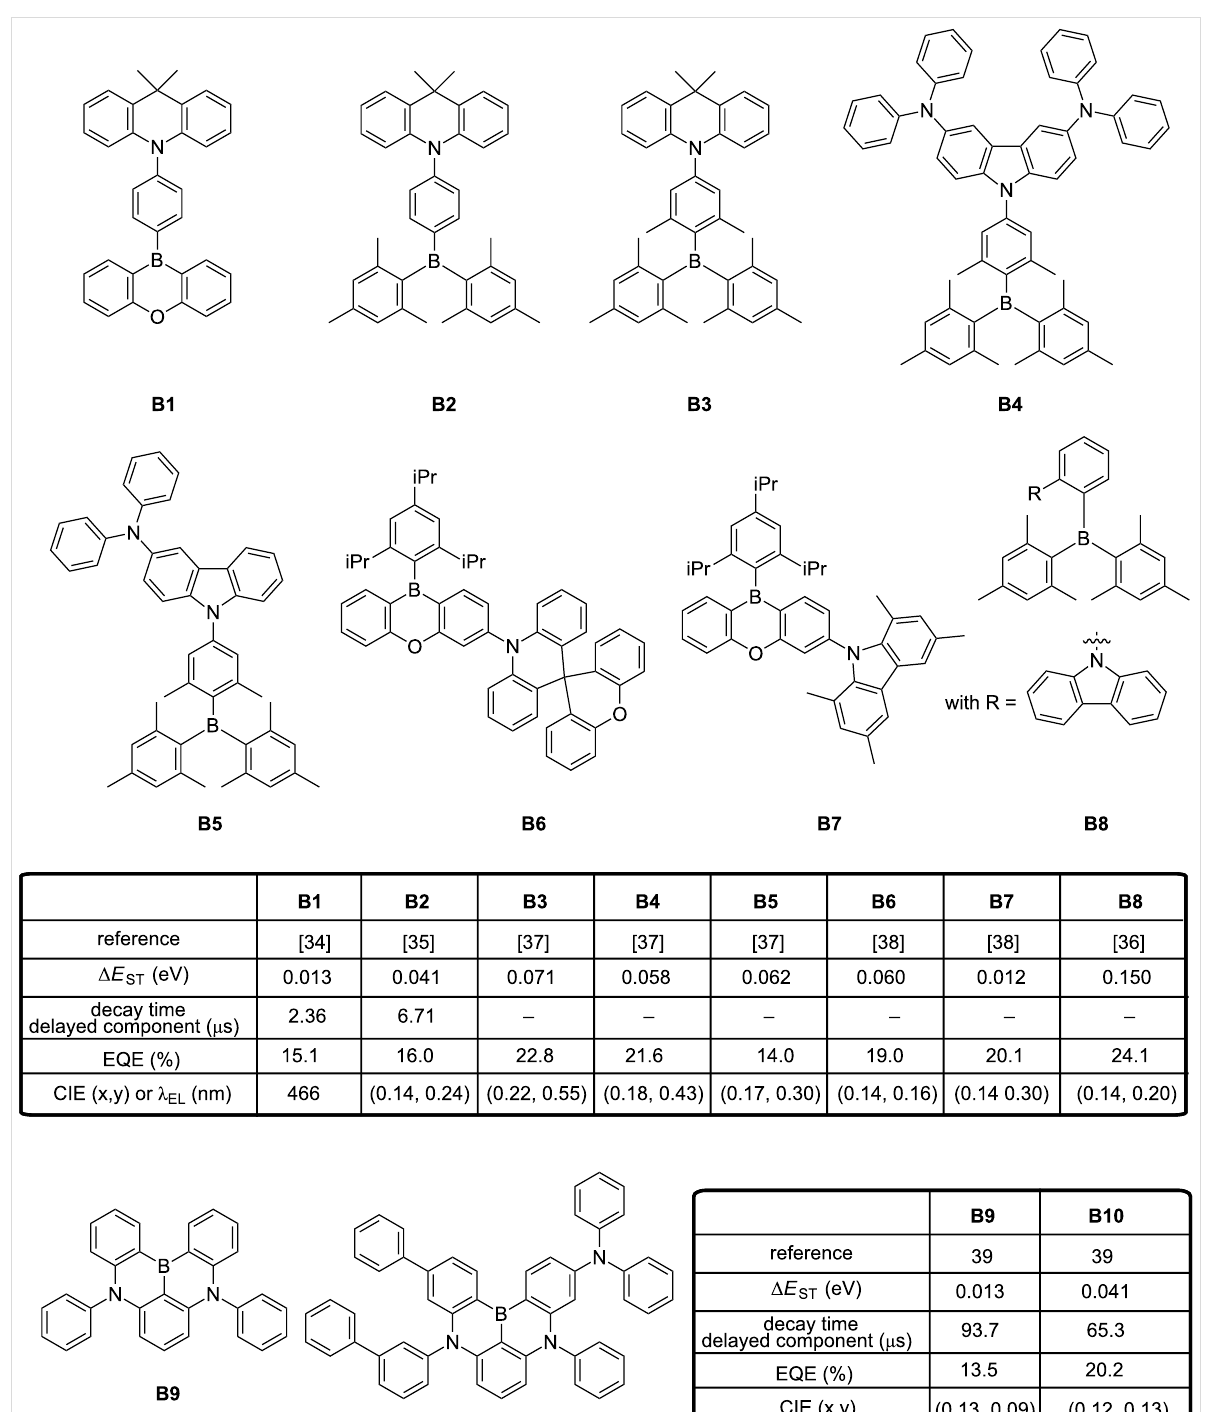
Figure 2: Boron-containing TADF emitters B1 – B10 .